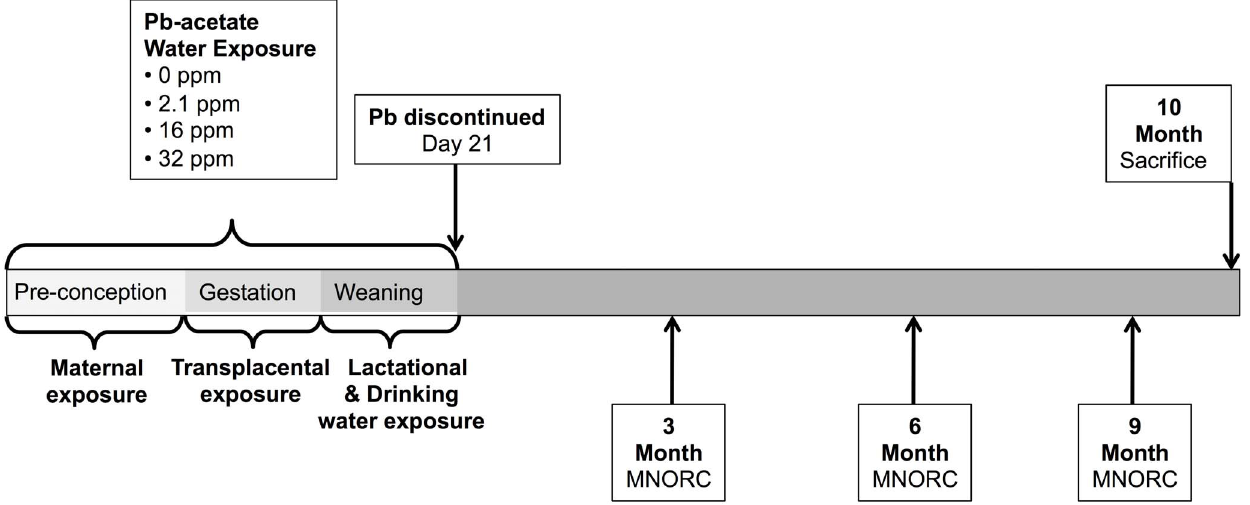
Figure 1. Lead Exposure Timeline. Dams were exposed 2 weeks prior to mating and throughout pregnancy. Pups continued exposure post- natally during lactation and via direct exposure in drinking water until weaning at day 22. After discontinuation of Pb exposure, mice were assayed for physiological parameters at 3, 6, and 9 months of age at the Michigan Nutrition Obesity Research Center (MNORC), and sacrificed at 10 months of age.